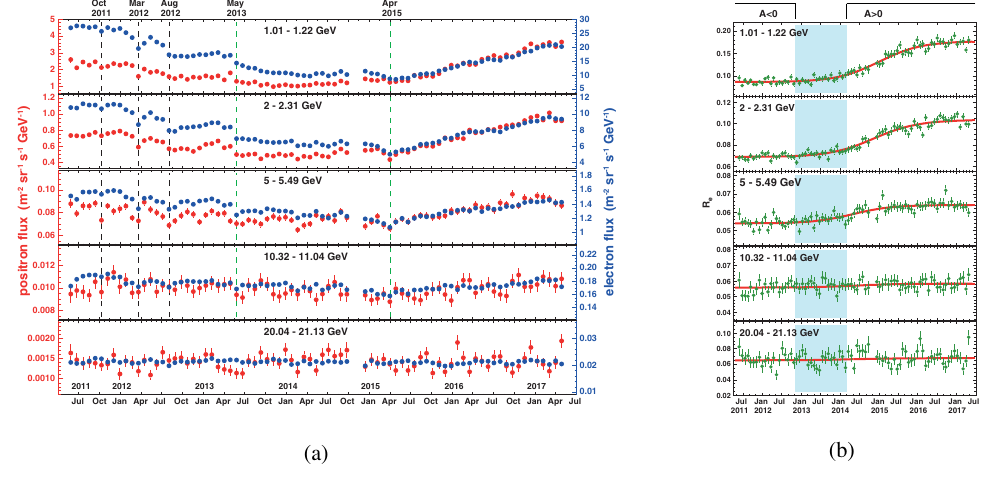
FIG. 2. Fluxes of primary cosmic-ray positrons (red, left axis) and electrons (blue, right axis) as functions of time, for five of the 49 energy bins. The error bars are the statistical uncertainties. Prominent and distinct time structures visible in both the positron spectrum and the electron spectrum and at different energies are marked by dashed vertical lines. Figure 1: ( a ) Fluxes of CRs e + (red, left axis) and e − (blue, right axis) as functions of time, for 5 energy bins with the statistical uncertainties. Prominent and distinct time structures are marked by dashed vertical lines. ( b ) The e + / e − ratio, R e , as a function of time with the statistical uncertainties. The red curves show a best-fit parametrisation obtained with an analytical function described in [3]. The polarity of the heliospheric magnetic field is denoted by A < 0 and A > 0. The period without well-defined polarity is marked by the shaded